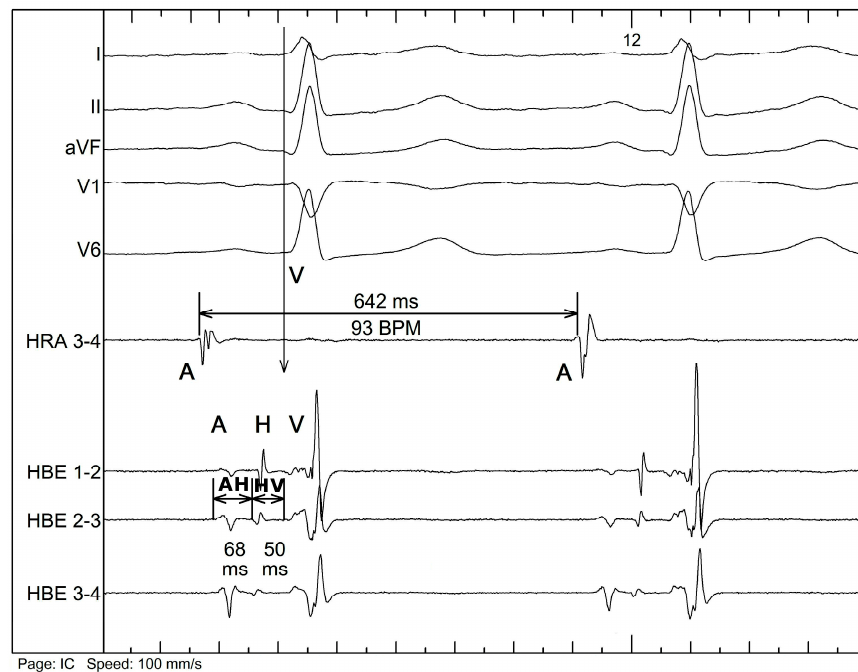
Figure 1. Example of signal labeling and interval measurement. HRA—high right atrium